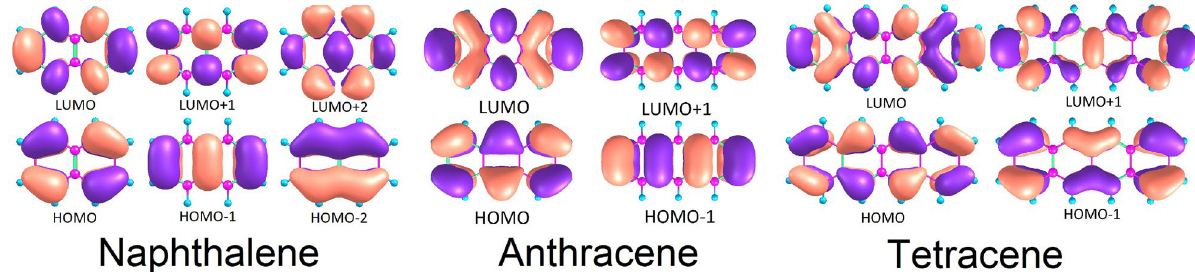
Figure 2. Highest occupied (lowest unoccupied) molecular orbitals HOMO (LUMO) for naphthalene, anthracene, and